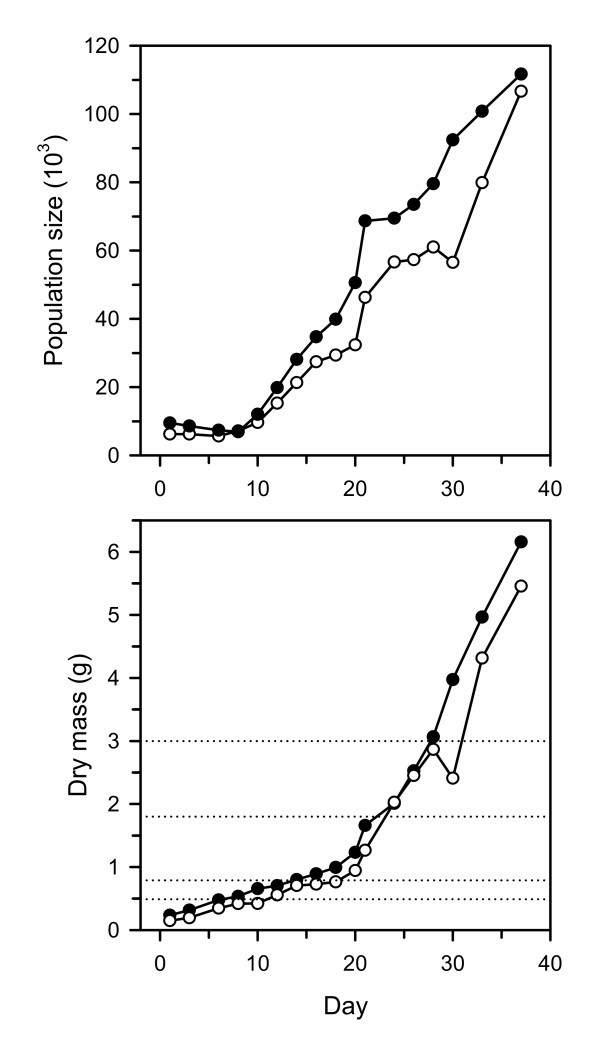
Population size and total dry mass of D. pulicaria in the two mesocosms (closed symbols = tower 1; open symbols = tower 2). Dotted lines delineate the biomass groups used for the analysis.